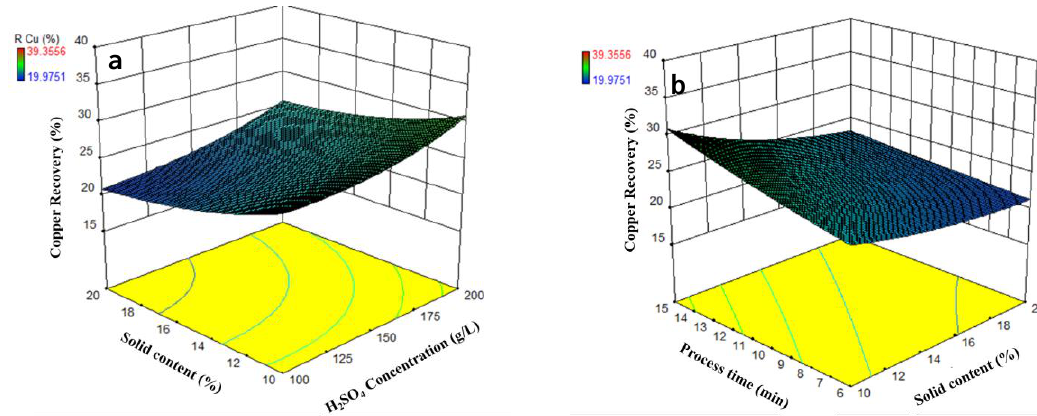
Figure 6. The solid content-H 2 SO 4 concentration ( a ) and process time-solid content ( b ) interactions (other parameters are held at center).